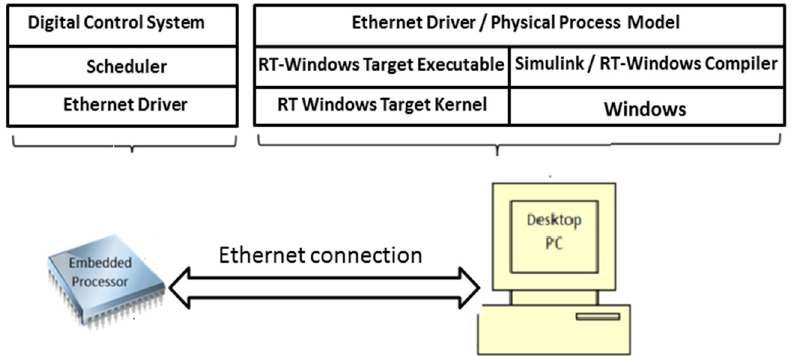
Figure 3. General architecture of the HIL testing facility.